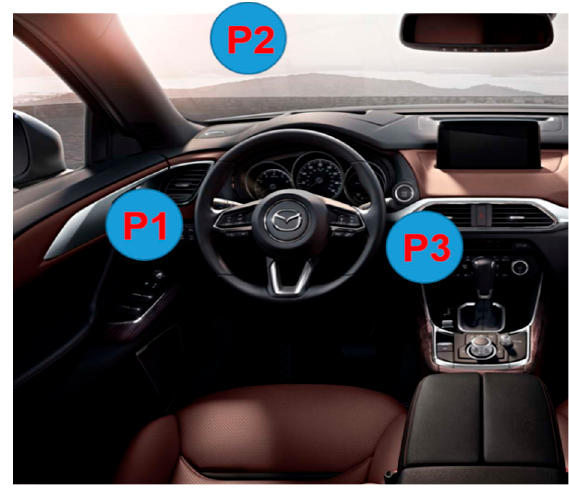
Figure 2. Evaluated radar locations.